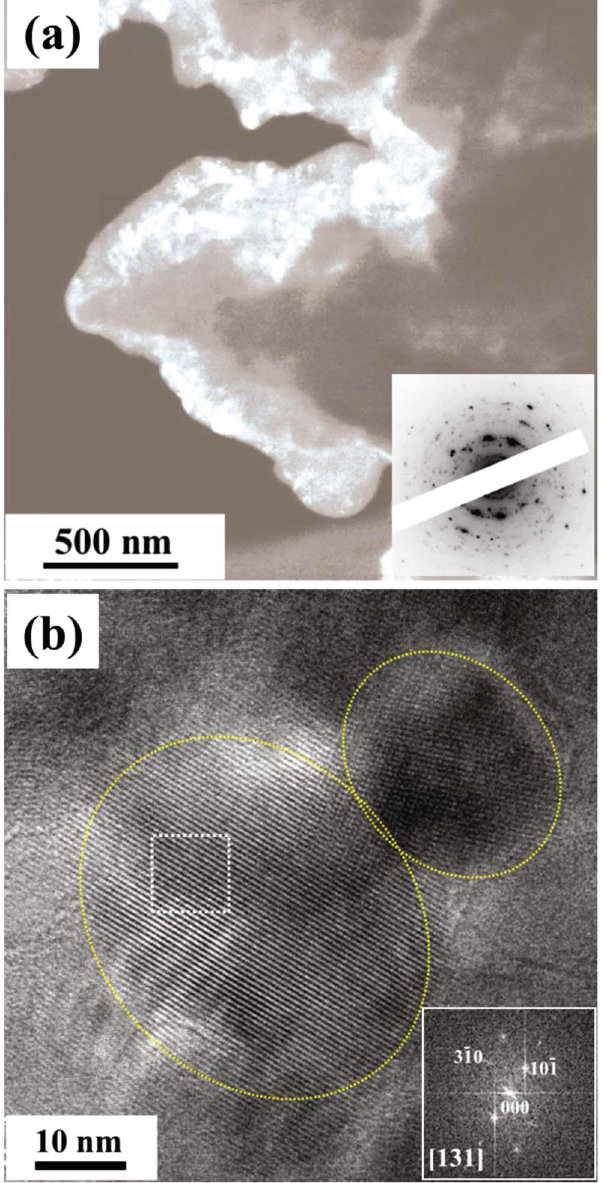
Figure 5. The DF image ( a ) and HR-TEM image ( b ) indicating the microstructure of the the 75Li 2 S·25P 2 S 5 glass ceramics, together with the corresponding ED and FFT pattern in the inset of ( a ) and ( b ), respectively. The FFT pattern was obtained from the dotted square regions in ( b